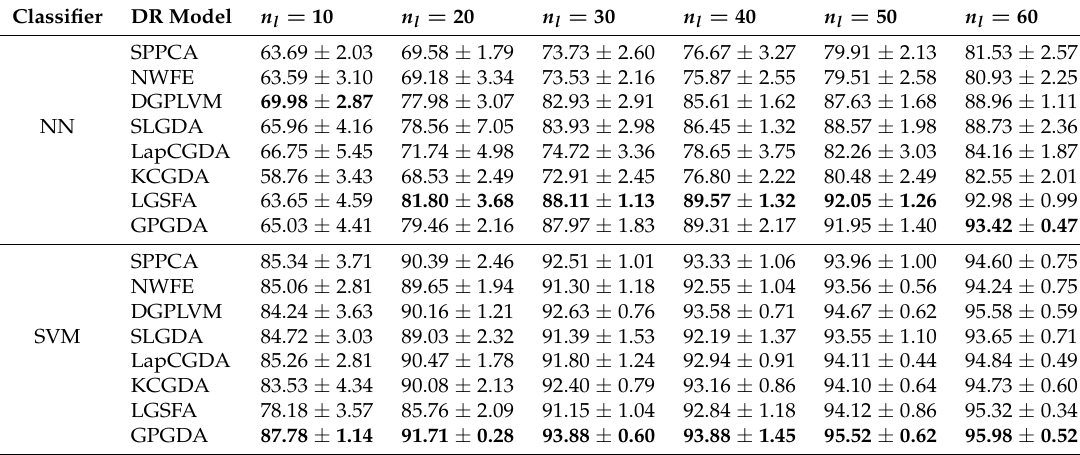
Table 7. Classification results with different amounts of training data on the University of Pavia data (OA ± STD (%)).